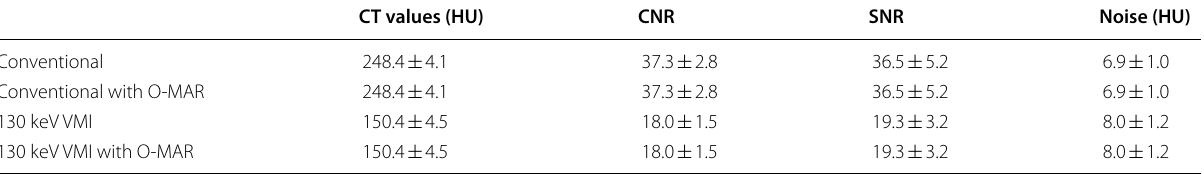
Table 2 Mean image quality parameters for conventional 140 kVp and 130 keV virtual monochromatic imaging with and without O-MAR, without insertion of prostheses. Values are the mean of all 18 pellets standard deviation ± CT values (HU) Noise